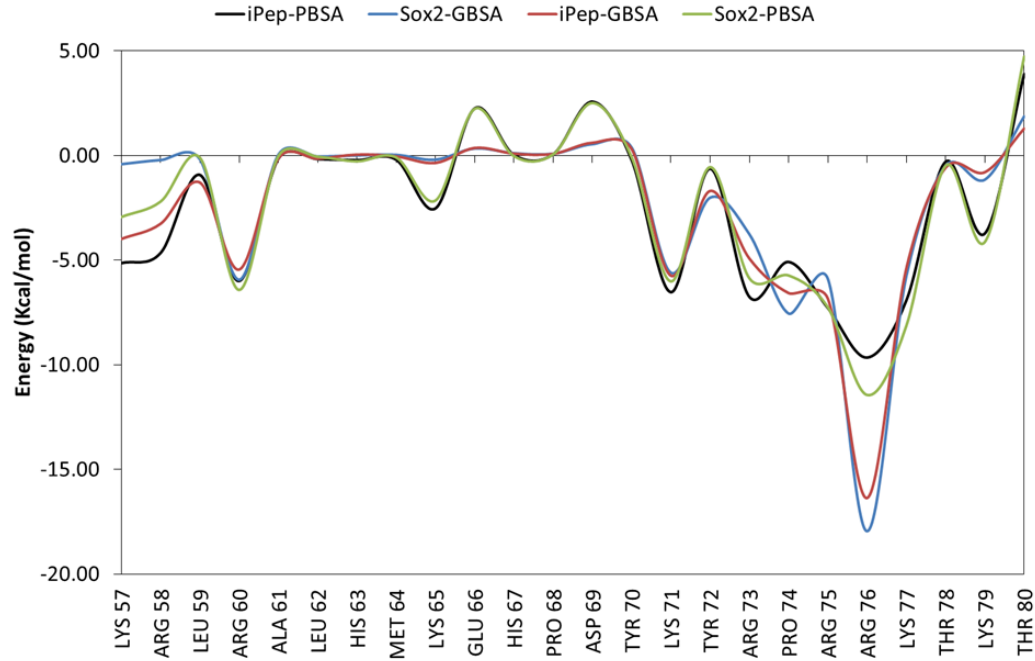
Figure 6. Free energy of binding decomposition per amino acid residue in the iPep and the corresponding C-terminus of SOX2. The free energies were calculated with both the PBSA and GBSA methods. SOX2 numbering is taken into account for this analysis.